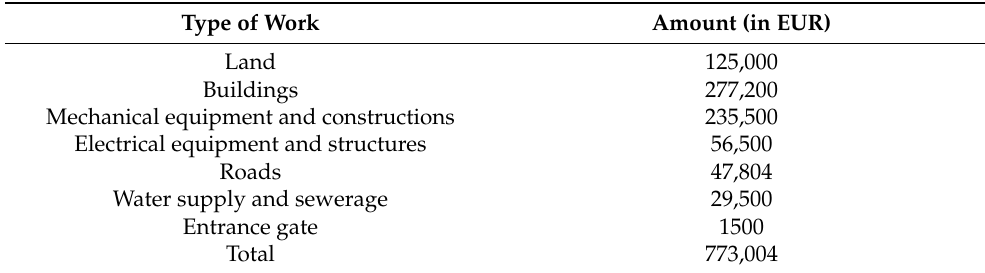
Table 1. Structure of project’s capital expenses.